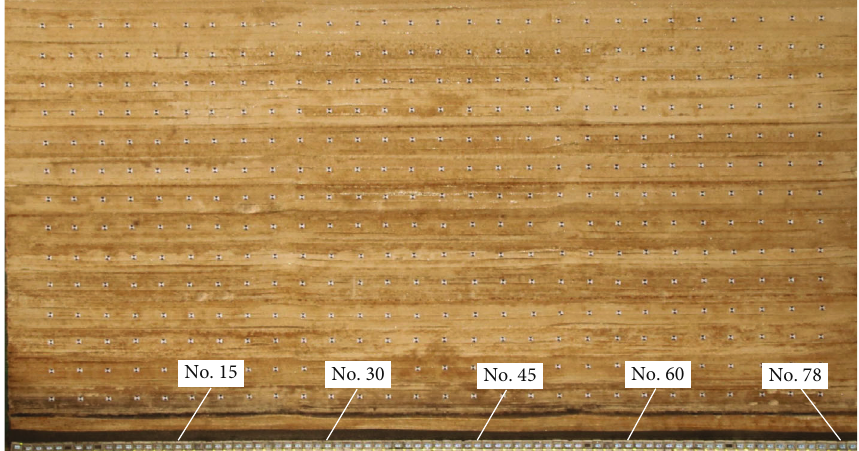
Figure 15: Position of pressure sensor at bottom of the coal